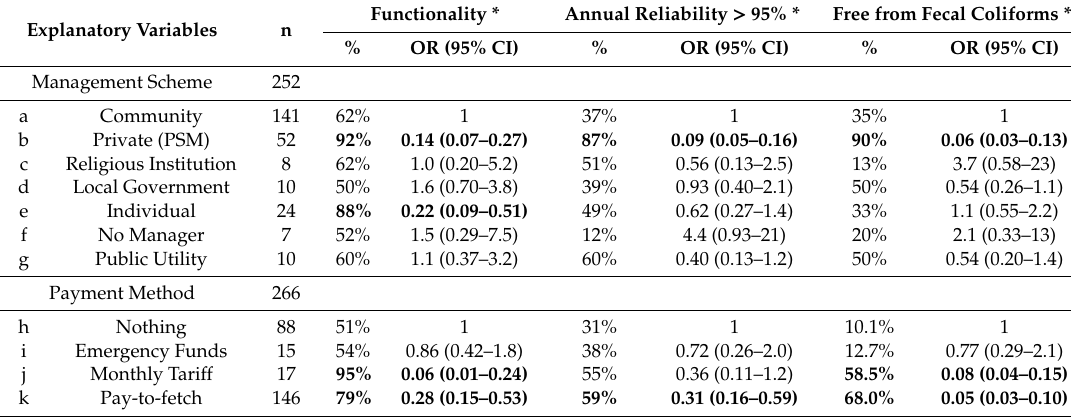
Table 3. Multinomial logistic regression of water source